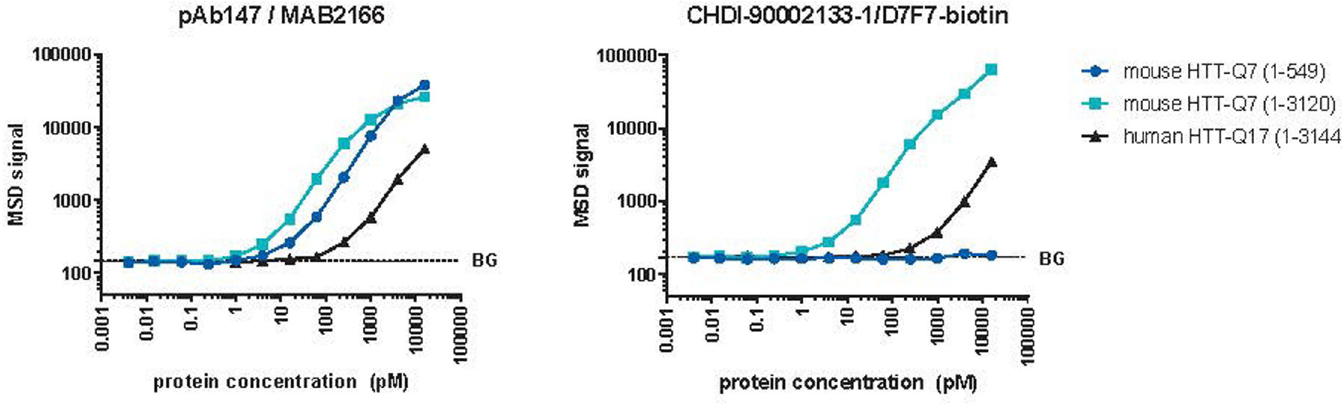
Fig 3. Performance of the mouse HTT MSD assay employing only monoclonal antibodies (mAb2133/D7F7) compared to assays using polyclonal antibodies (pAb147/MAB2166). Recombinant HTT protein curves representing mouse HTT-Q7, 1–549, full-length mouse HTT-Q7 and full-length human HTT-Q17. Please note the logarithmic scales used and that the error bars are smaller than the symbol used in the graph and therefore cannot be seen.